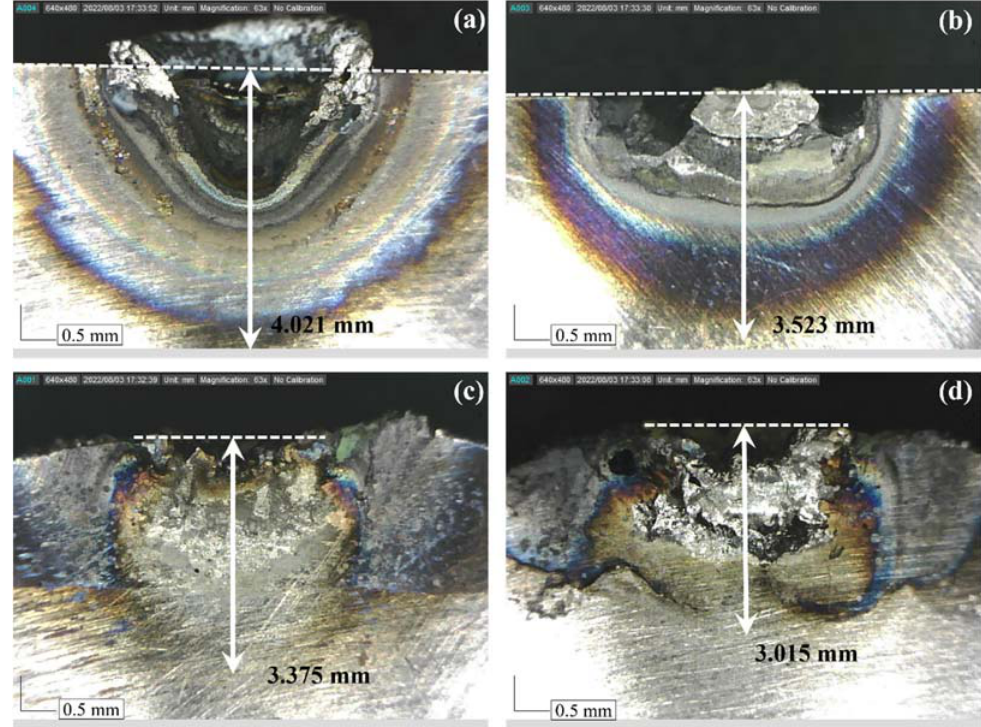
Figure 12. The measurement results of the HAZ: ( a ) Ti ‐ 6Al ‐ 4V, ( b ) Inconel 718, ( c ) Ti ‐ Nb ‐ Cr ‐ V ‐ Ni ‐ Al deposited on Ti ‐ 6Al ‐ 4V, and ( d ) Ti ‐ Nb ‐ Cr ‐ V ‐ Ni ‐ Al deposited on Inconel 718.